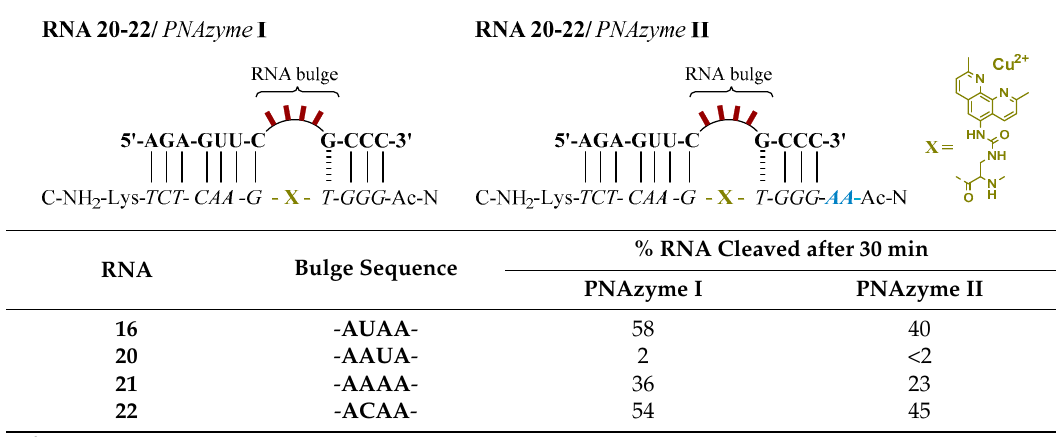
Table 3. Schematic representation of complexes between 4-nucleotide bulge-forming RNA sequences 20 – 22 and PNAzyme I or II, followed by the extent of cleavage of RNAs 16 and 20 – 22 after incubation in the presence of PNAzyme I or II over a period of 30 min. 3